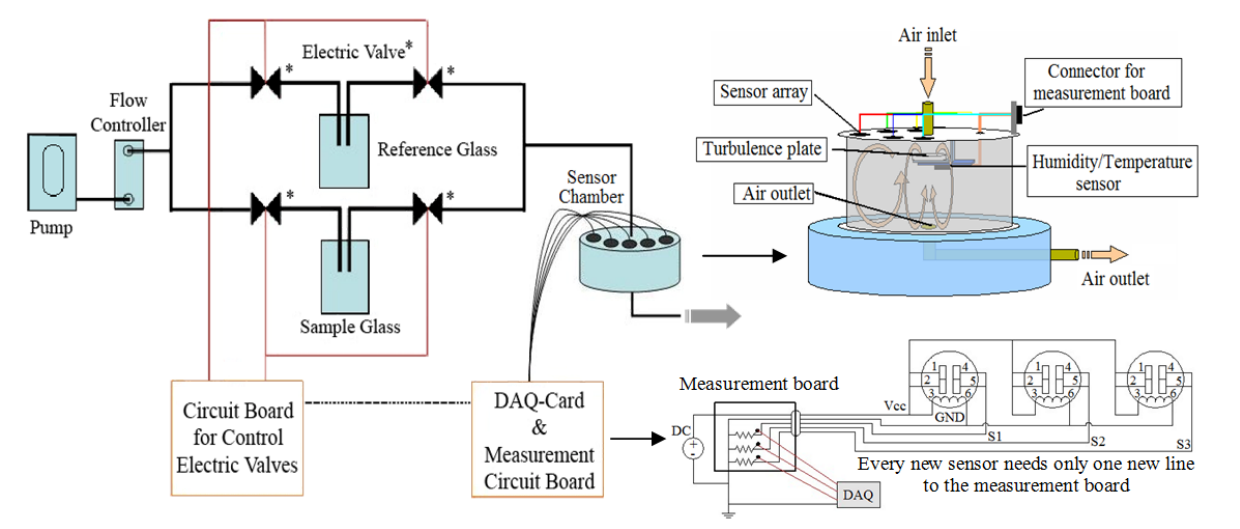
Figure 1. Schematic diagram of the lab-made E-nose system.